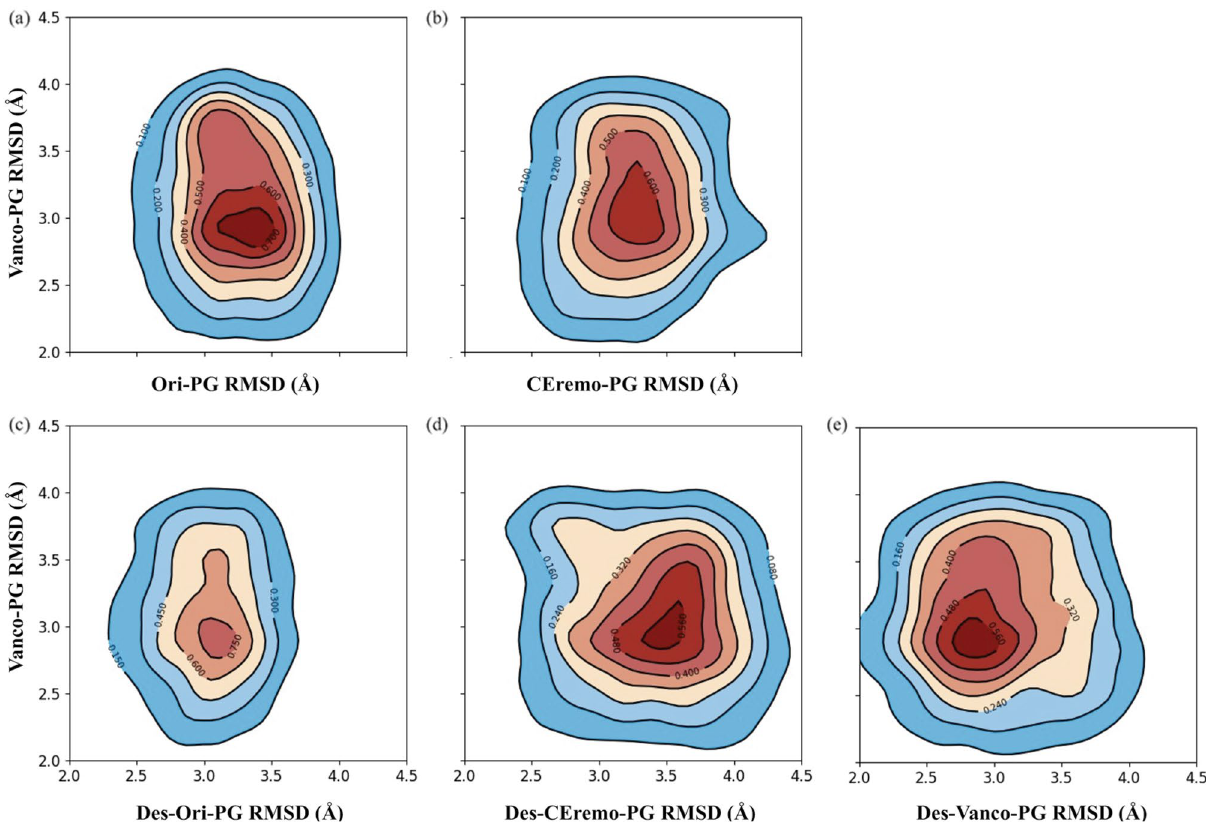
Figure 5. Comparative 2D rmsd ( Å ) contour plots of the Ori–PG complex relative to the other complexes. Comparative 2D rmsd contour plots of ( a ) Ori–PG vs. Ceremo–PG, ( b ) Ori–PG vs. Vanco–PG, ( c ) Ori–PG vs. Des-Ori–PG, ( d ) Ori–PG vs. Des-CEremo–PG, and ( e ) Ori–PG vs. Des-Vanco–PG complexes. The contour lines are the densities of trajectories located within an area. The region of the highest density of trajectories is denoted by the red color, while the blue colors represent regions of lower densities of